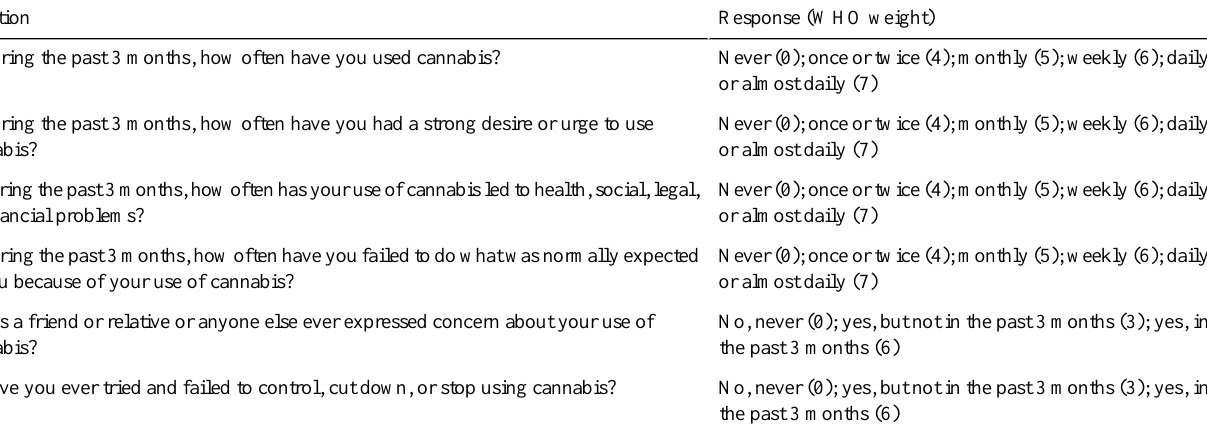
Table 2. ASSIST score questions, possible responses, and WHO weights [28]. ASSIST: Alcohol, Smoking, and Substance Involvement Screening Test; WHO: World Health Organization.